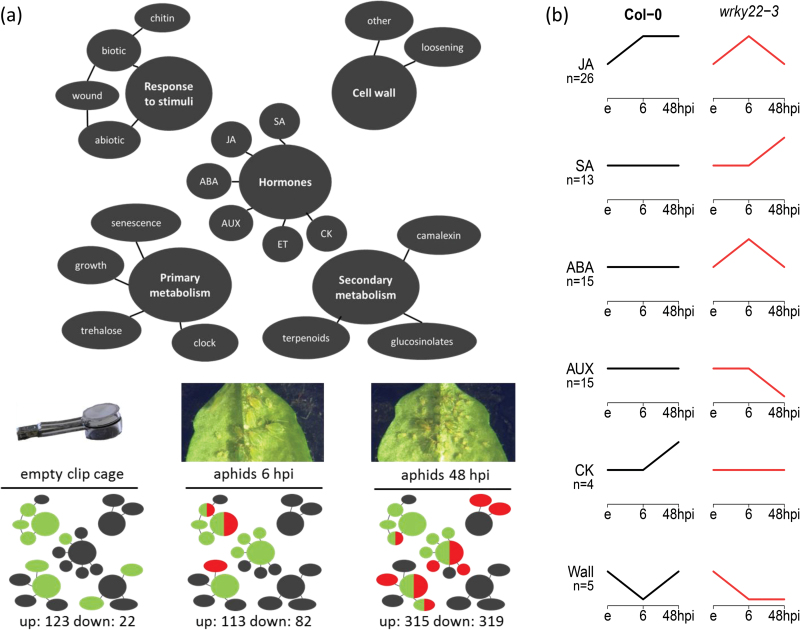
Enriched biological processes in wrky22-3. (A) Over-representation of biological processes in the knockout relative to the wild-type. Balloons refer to a process, or to the biosynthesis of, or responsiveness to the respective compound (SA: salicylic acid; JA: jasmonic acid; ABA: abscisic acid; AUX: auxin; ET: ethylene; CK: cytokinin; clock: circadian clock). Balloon colour indicates enrichment in the knockout (green: up-regulated; red: down-regulated; green/red: both up- and down-regulated; the total number of DE genes is depicted below the charts). (B) Relative expression patterns between treatments within each plant line. Only the dominant pattern (≥50% of the genes) of significant perturbations (≥2-fold, q-value <0.05) between treatments with and without aphids is shown. (Wall: cell wall loosening; n: number of genes associated with the biological process; e: empty clip cage; 6: 6 hpi.)